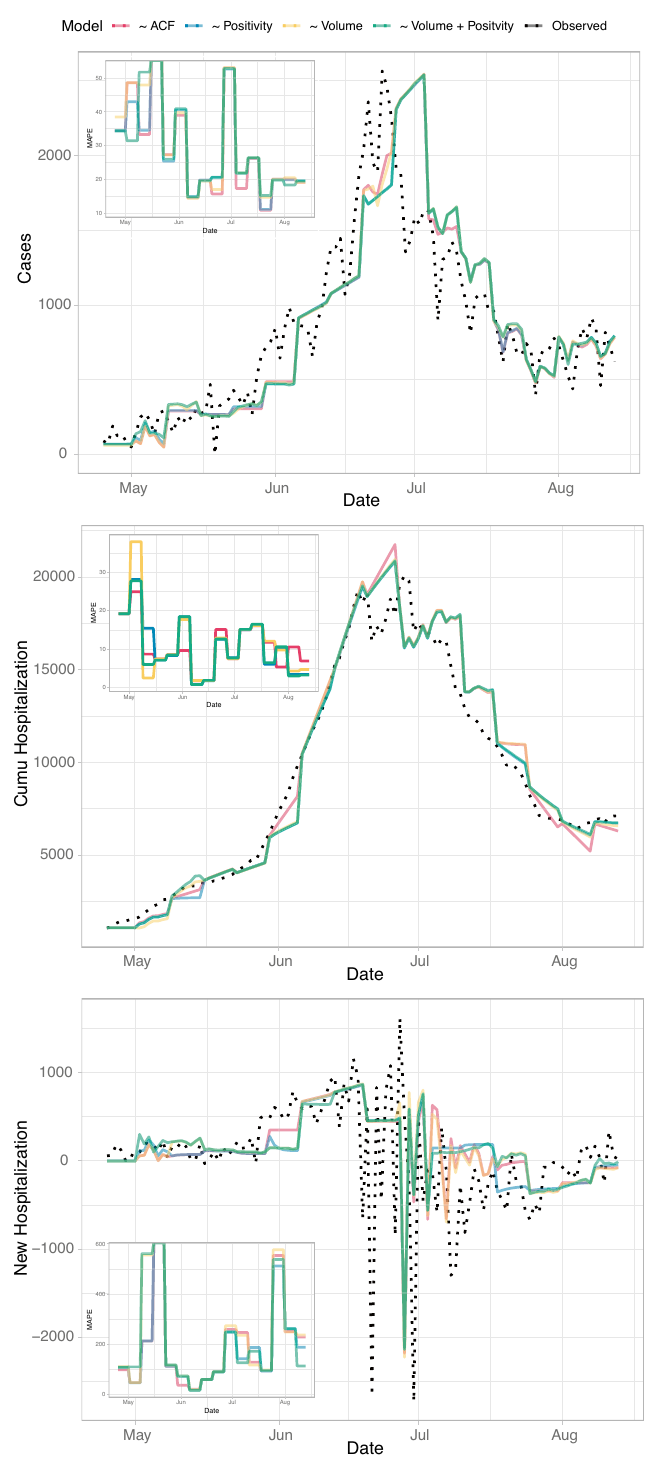
Figure 8. Hospitalization and case forecasting for different predictive models. The results of ARIMA forecasts with different models in terms of predictors are shown for cases, cumulative and new hospitalization (top to bottom) for New Delhi. ACF is ARIMA based on epidemiological data only, while all other ARIMA models are based on positivity, Tweet volume, Tweet volume and positivity combined (red, blue, yellow, and green curves). Black dots are from observations at the city scale. All curves are at the daily